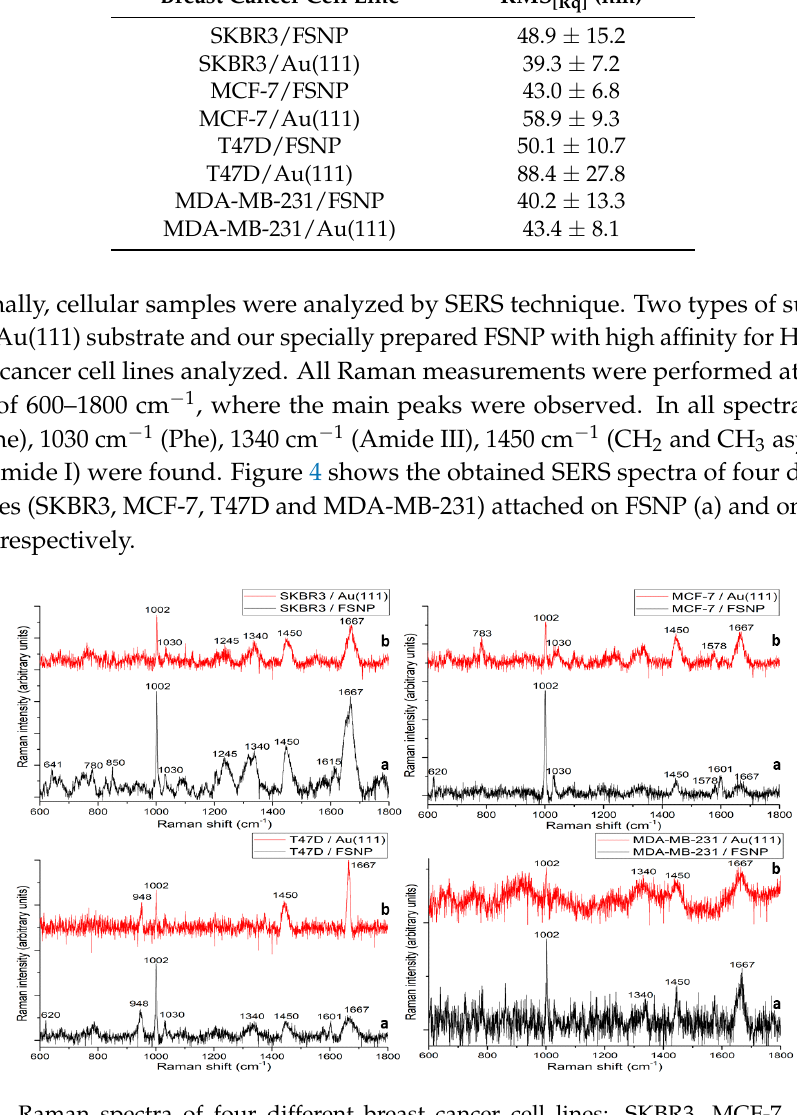
Figure 4. Raman spectra of four different breast cancer cell lines: SKBR3, MCF-7, T47D and MDA-MB-231 ( a ) attached on a FSNP and ( b ) attached on a flat substrate of Au(111).